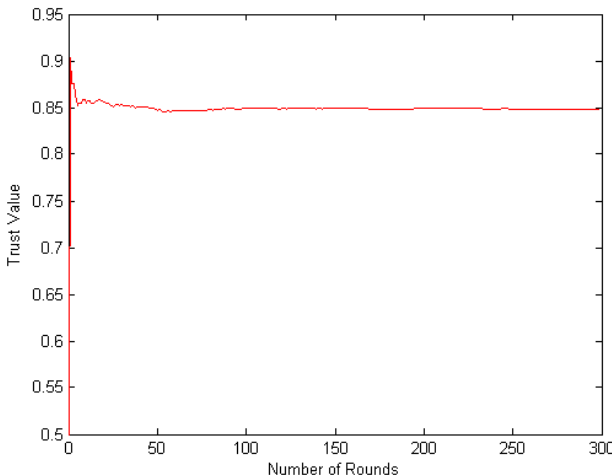
Figure 3. Trust value change for interaction between normal nodes.